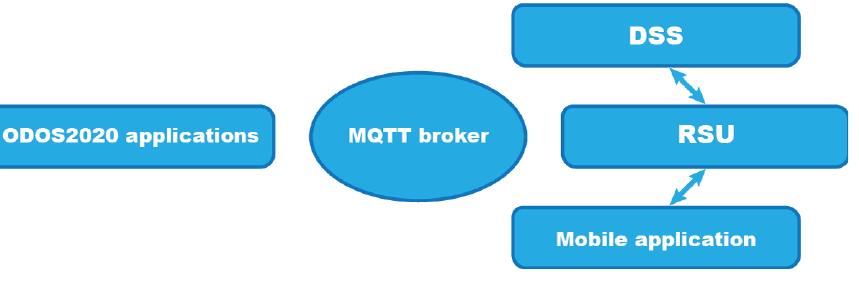
Figure 2. HMI system architecture rationale.